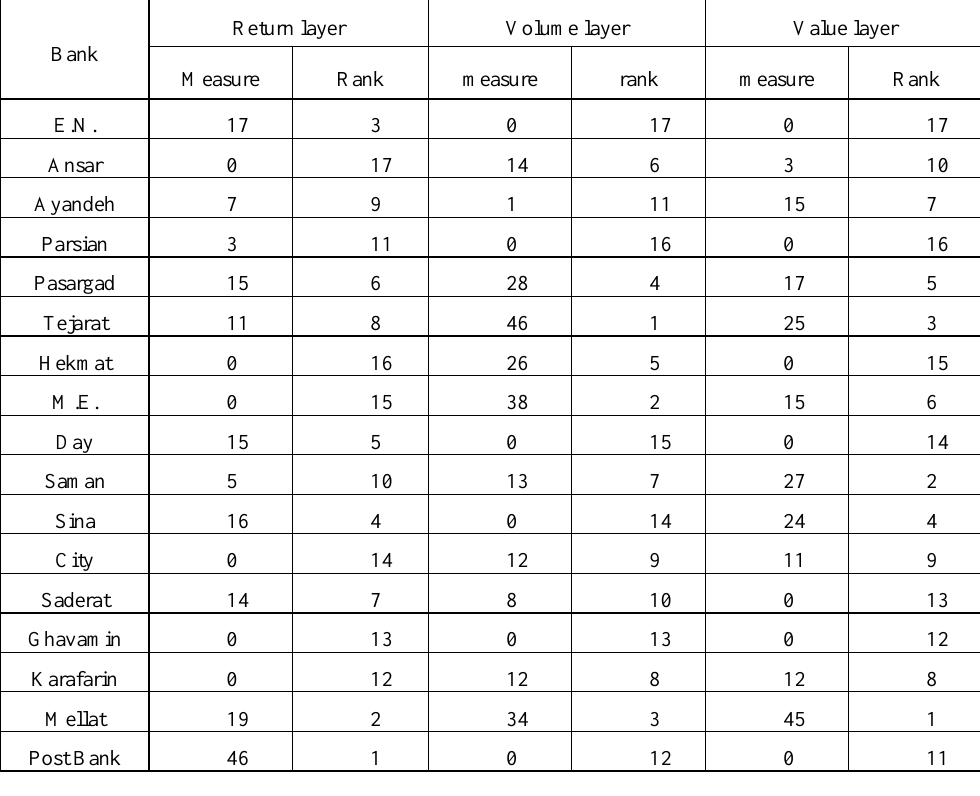
Table 4. Betweenness centrality in each layer